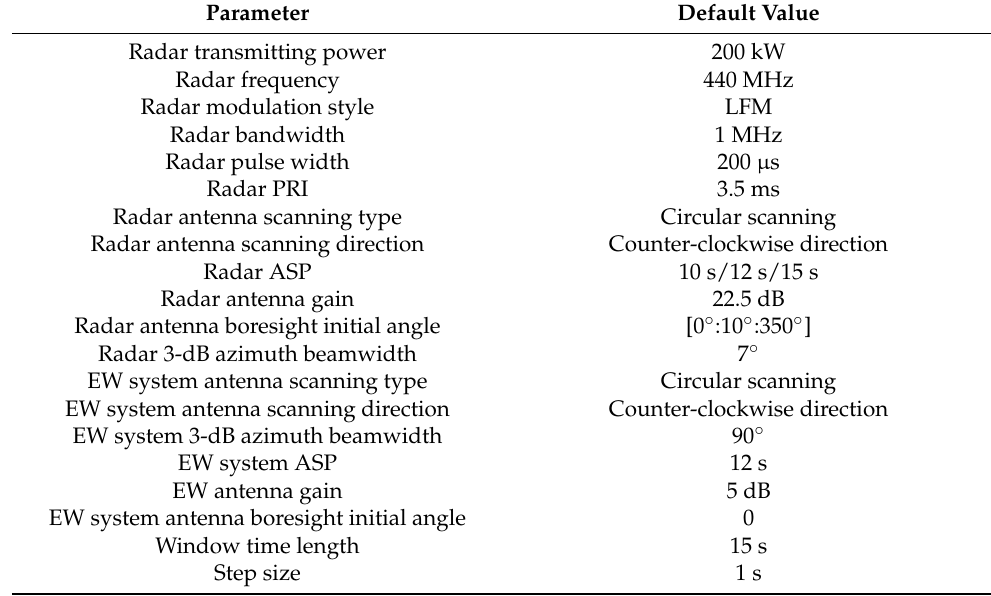
Table 2. Parameters of numerical